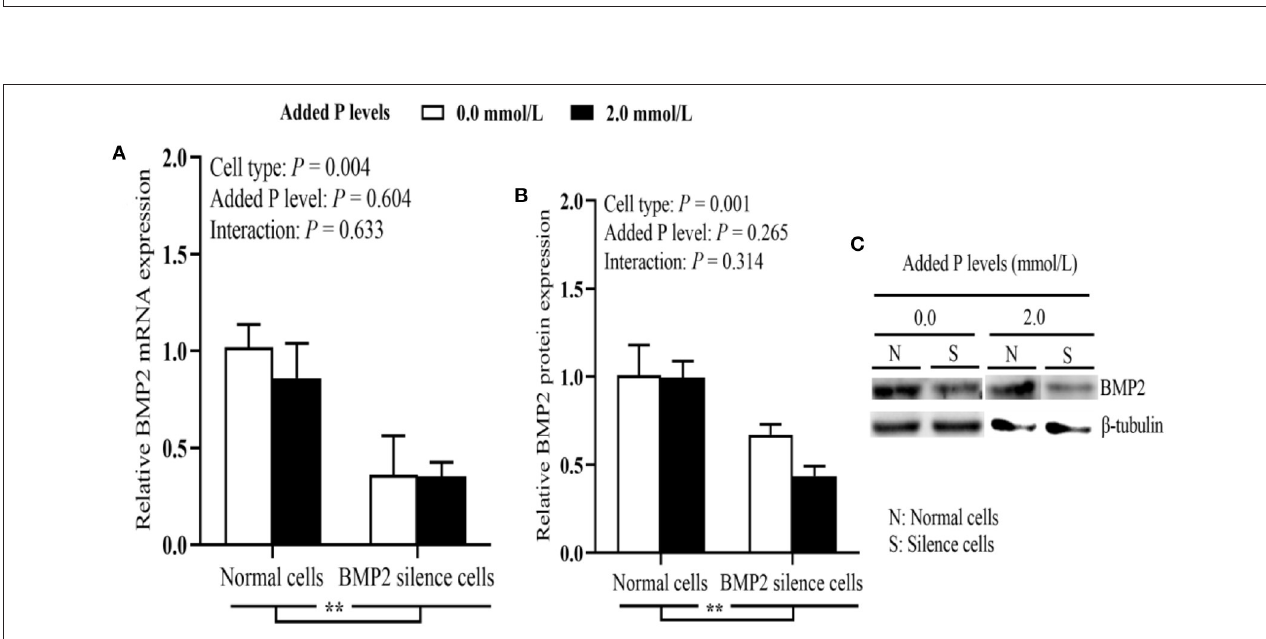
FIGURE 3 | Effects of cell types and P levels on the tibial osteoblastic BMP2 mRNA (A) and protein expressions (B,C) in primary broiler osteoblasts (experiment 2). Each value represents the means ± SE, n = 4. ** P < 0.01. BMP2, bone morphogenetic protein 2; P, Phosphorus.